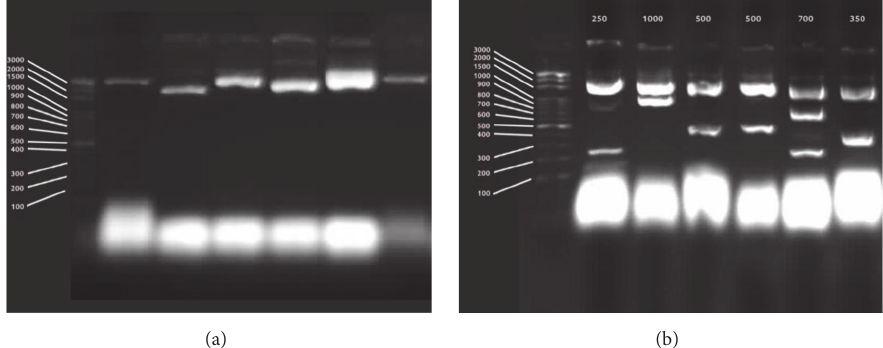
Figure 2: (a) Postnatal cDNA clones obtaining with alkaline lysis method. (b) Cutting of postnatal cDNA clones with Bsp1407I restriction enzyme.